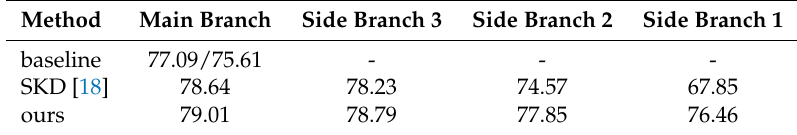
Table A1. Accuracy (%) comparison on CIFAR-100